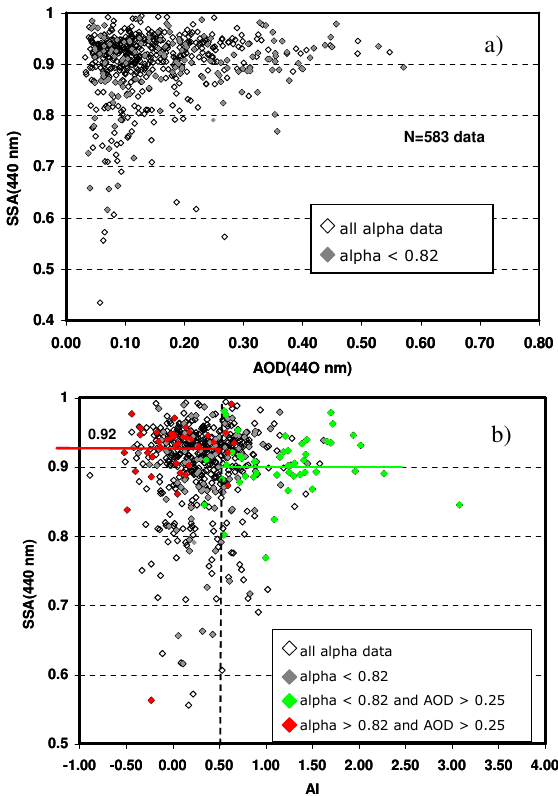
Fig. 5. (a) Mean day values of SSA at 440nm “(level 1.5)” as function of AOD at 440nm for the El Arenosillo station for the 2004–2008 period and (b) as function of AI, where different sub- sets of aerosols specified by alpha and AOD(440nm) values are represented (see text). “all alpha data” set includes white and other coloured